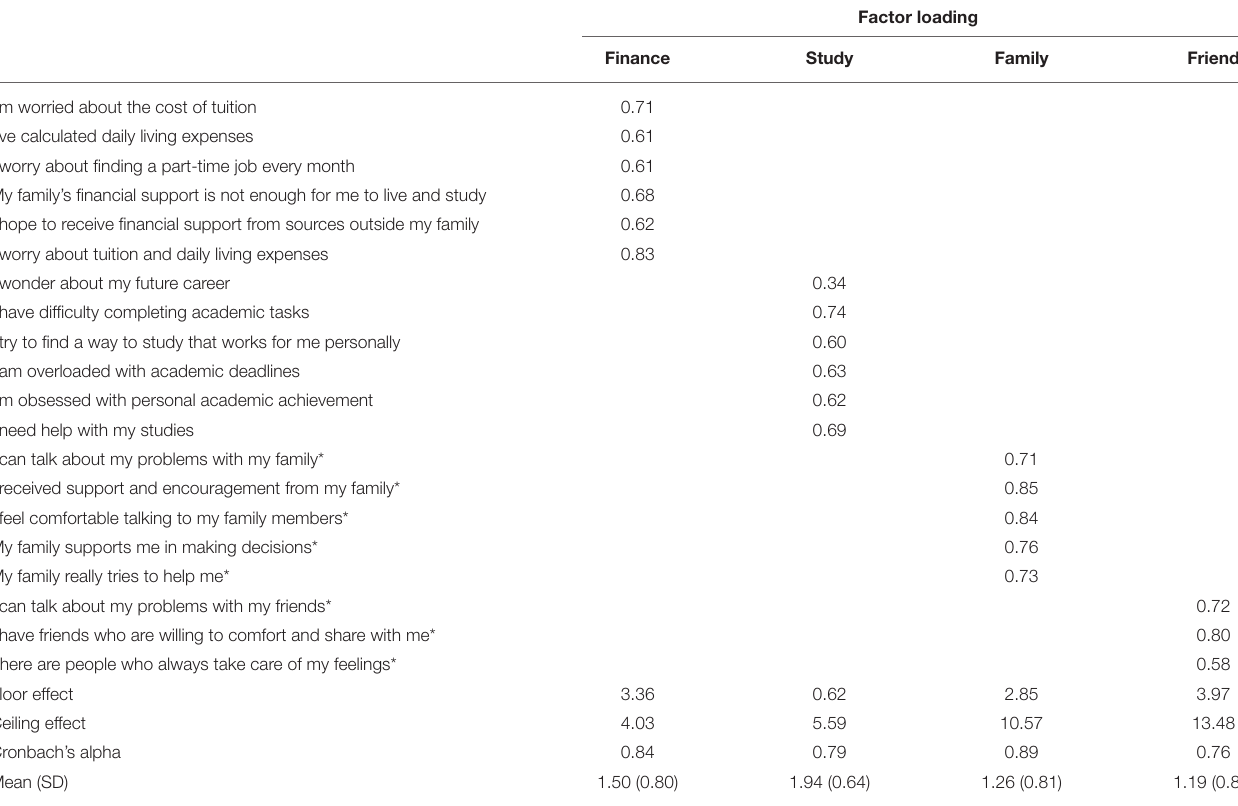
TABLE 2 | Properties of FSFF